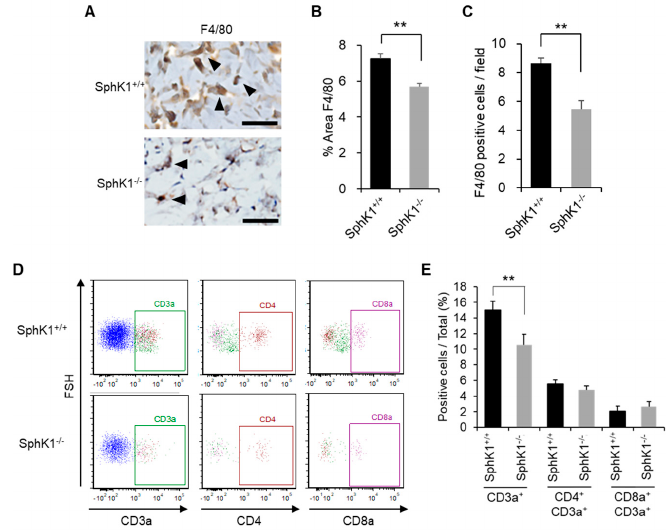
Figure 3. Effect of SphK1 knockout on inflammatory cell recruitment during wound healing. ( A ) Representative images of F4/80 expression on immunohistochemistry are shown. Arrowheads indicate positive findings (scale bars: 50 µm). ( B ) The percentage of the wound area that is occupied by F4/80 + cells is graphed ( n = 4). ( C ) The number of F4/80 + cells per field is graphed ( n = 4). ( D , E ) Representative flow cytometric plots (D) and frequency of the indicated T cell populations (E) on Day 5 after wounding, as determined by flow cytometry ( n = 5–8). All values shown in this figure represent the mean ± s.e.m. ** p < 0.01.